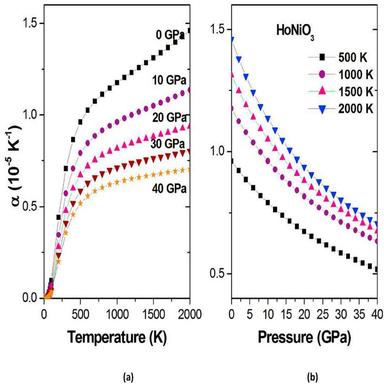
The value of αV as a function of the temperature (pressure) at different given pressures (temperatures).